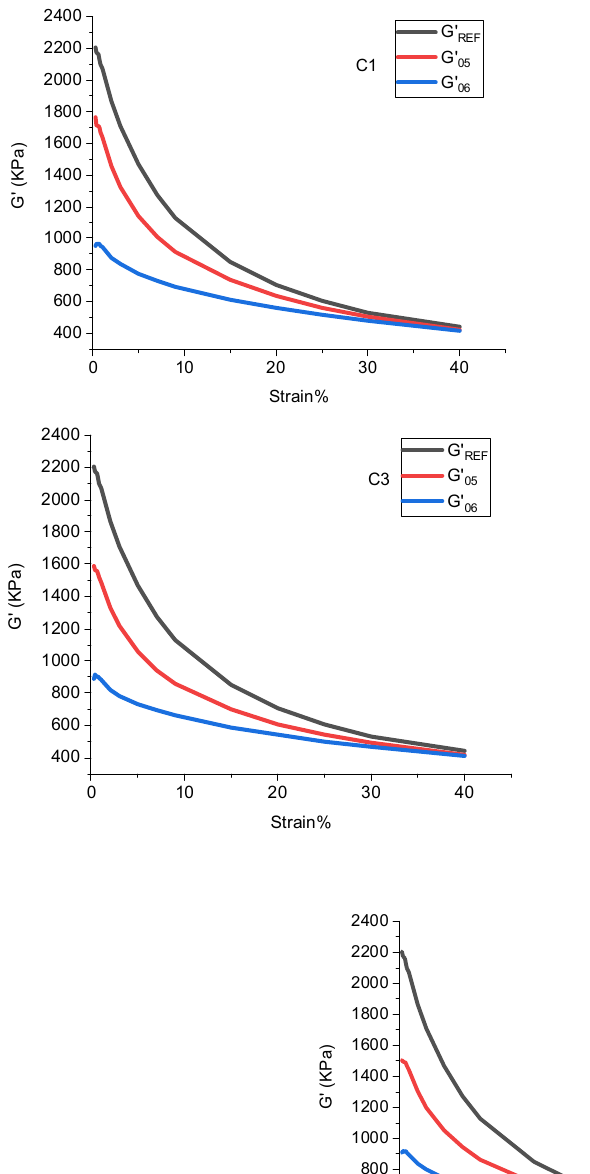
Table 5. Silanization reaction index of five blends.